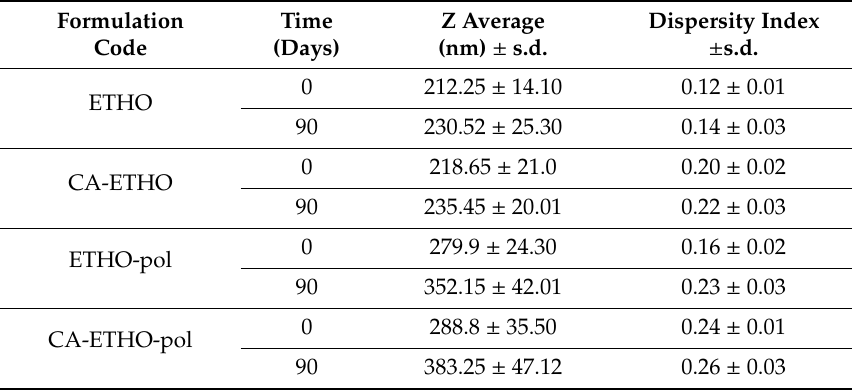
Table 2. Dimensional distribution parameters of ethosomes and ethosome gels, as determined by photon correlation spectroscopy (PCS). Formulation Time Z Average